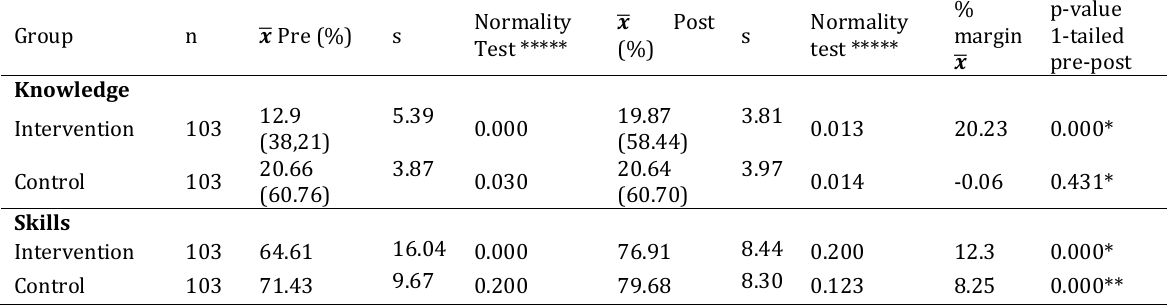
Table 4. The effect of the KOGUSIGA Intervention Model towards the Knowledge and Skills of Families in the Intervention and Control Groups (n